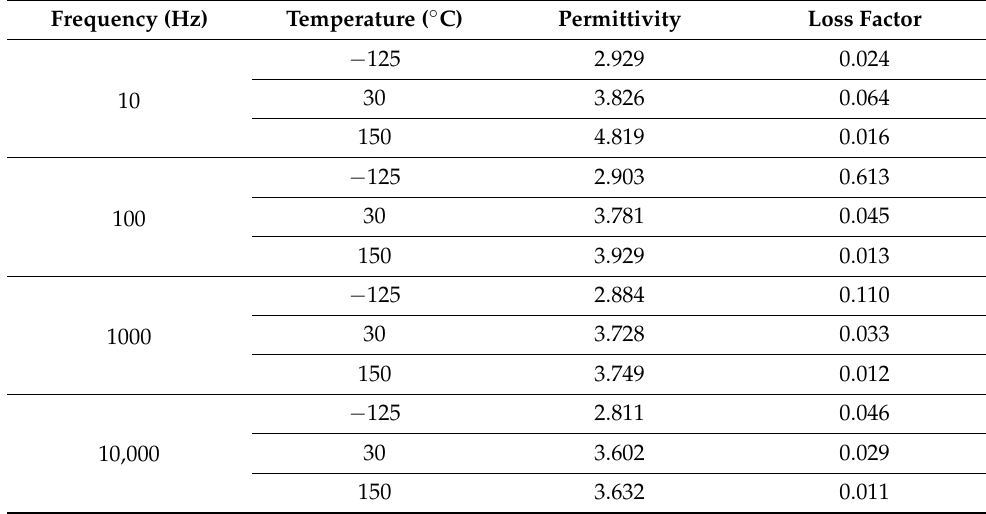
Table 6. Permittivity and loss factor of cured resin at 10, 100, 1000 and 10,000 Hz, and − 150, 30 and 150 ◦ C, at BP:B10 = 2:1.